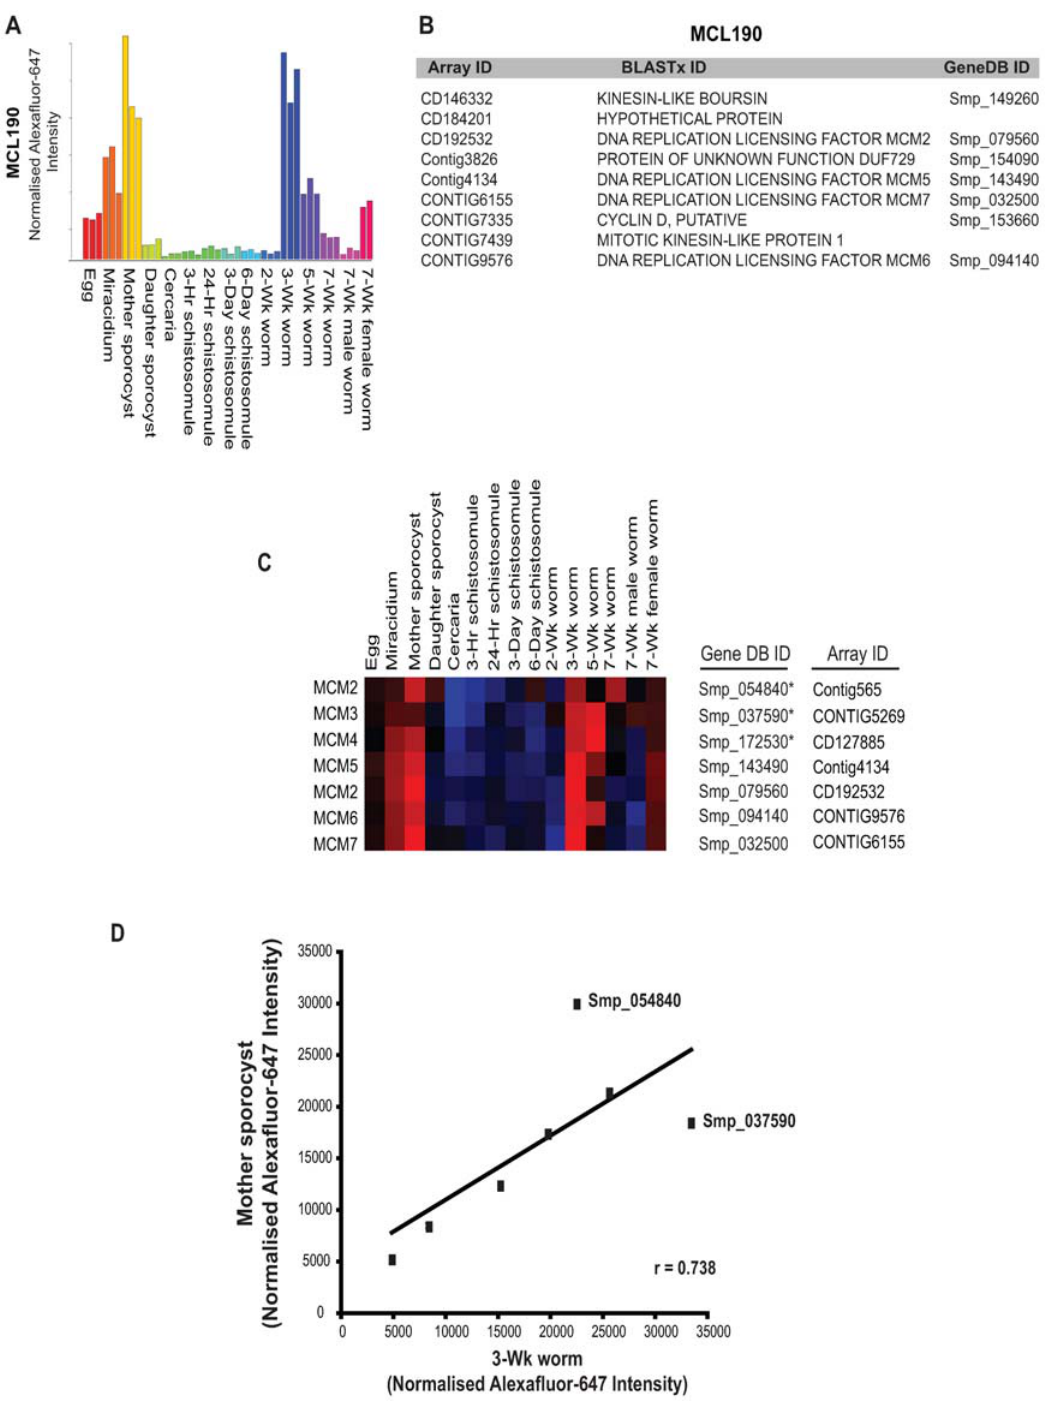
Figure 6. The minichromosome maintenance (MCM) heterohexamer is coordinately expressed in both mother sporocysts and 3- week adult worms. A) MCL190 identified 9 gene products sharing a peak of gene expression in the mother sporocyst and 3-wk adult worms. Bar graphs represent average normalised AF647 intensity values (Dataset S4) for all transcripts in MCL190, with replicate values obtained from independent life-stage hybridizations indicated as identical colours. B) List of genes contained within MCL190 demonstrates the presence of 4 out of the 6 transcripts constituting the eukaryotic MCM heterohexamer. C) Heatmap (Spearman’s rank correlation coefficient, average linkage clustering, red – highly expressed, blue – weakly expressed) of all 6 MCM heterohexamer subunits (Dataset S10, including two MCM2 paralogs) defined by both array and GeneDB identifiers (ID). * indicates three MCM transcripts not clustered within MCL190. D) Scatterplot of MCM heterohexamer normalised AF647 intensity units in mother sporocyst versus 3-wk worm samples. A correlation coefficient of 0.738 suggests coordinated expression of the MCM heterohexamer with individual outliers (Smp_054840 and Smp_037590) indicated.